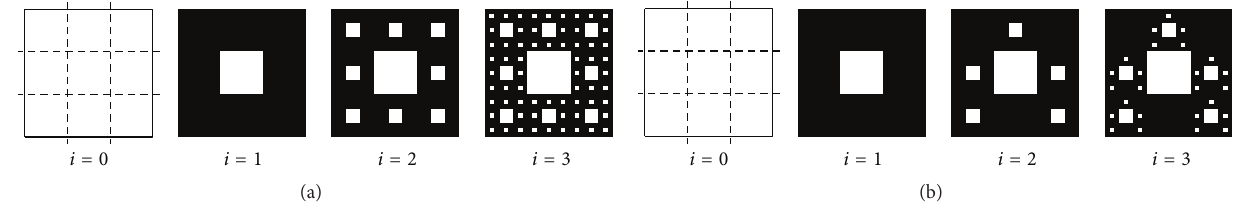
Figure 1: Sierpinski carpet construction: (a) all the eight subsquares are involved in self-similarity process; (b) only five subsquares reproduce the configuration of the first iteration, and the other three remain solid forever